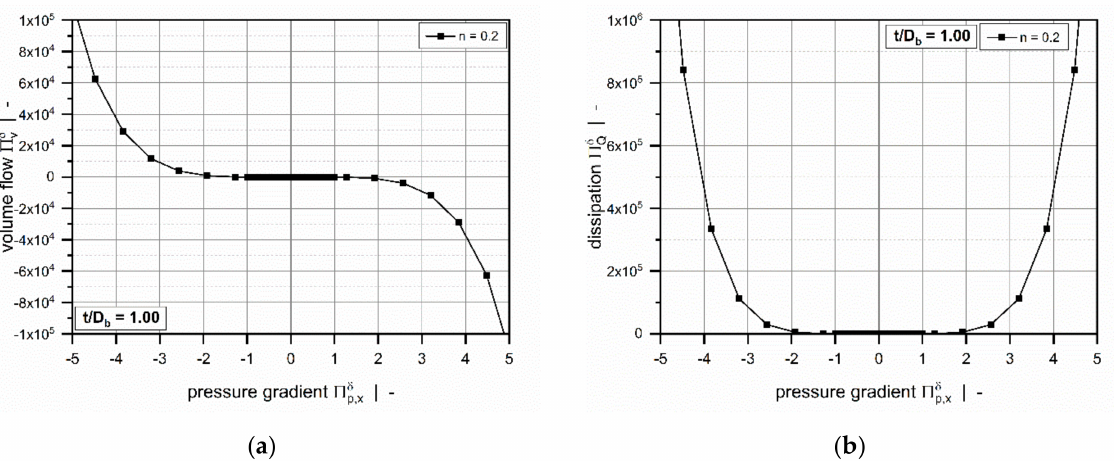
Figure 9. The dimensionless volume flow rate Π δ pressure gradient Π δ p , x for a square-pitched screw with t / D b = 1.0 and a polymer melt with the power-law index n =